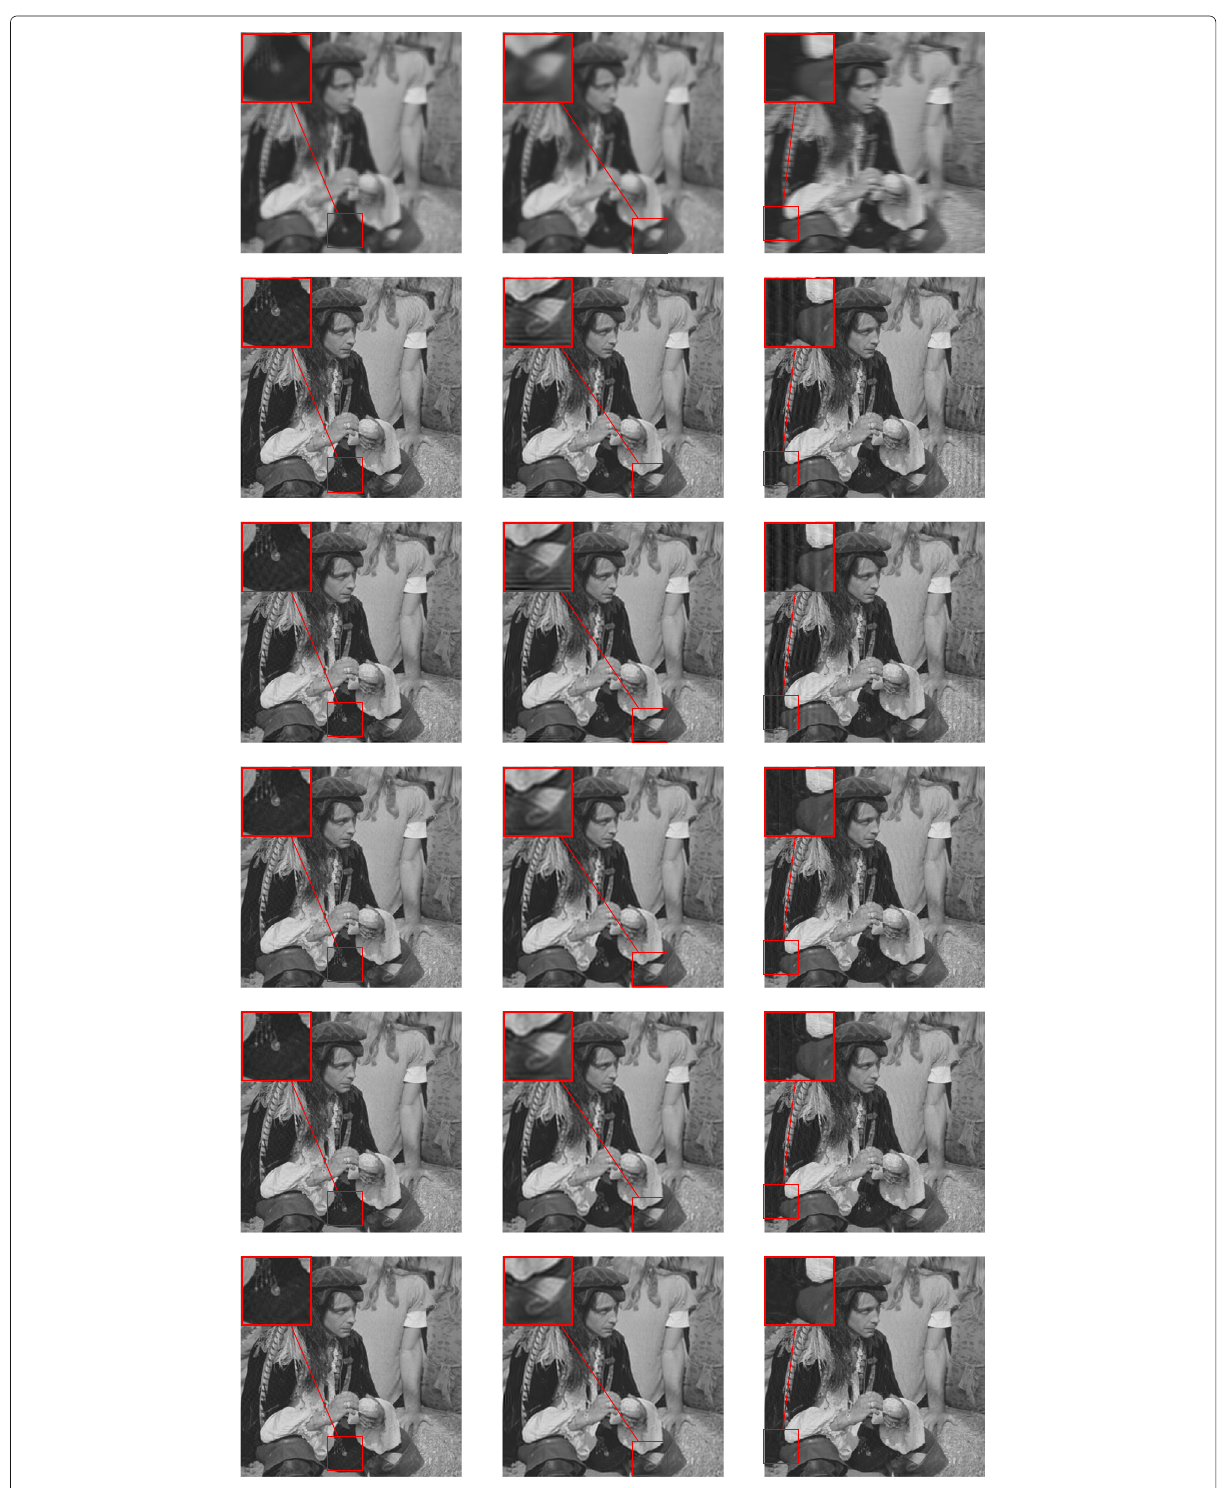
Fig. 7 Deconvolution of Pirate image. From left to right, the first column represents degradation by kernel 1, the second column for the degradation by kernel 2, and by kernel 3 in the third column. From top to bottom, the order of the rows is as follows: blurred images using the three kernels respectively, restored images using RL algorithm [11] (kernel 1 (iterations = 130), kernel 2 (iterations = 230), and kernel 3 (iterations = 80)), restored images using Wiener filter [9], restored images using TV method [14], restored images using BTV approach [16], and finally the restored images using our proposed MAP- H 1